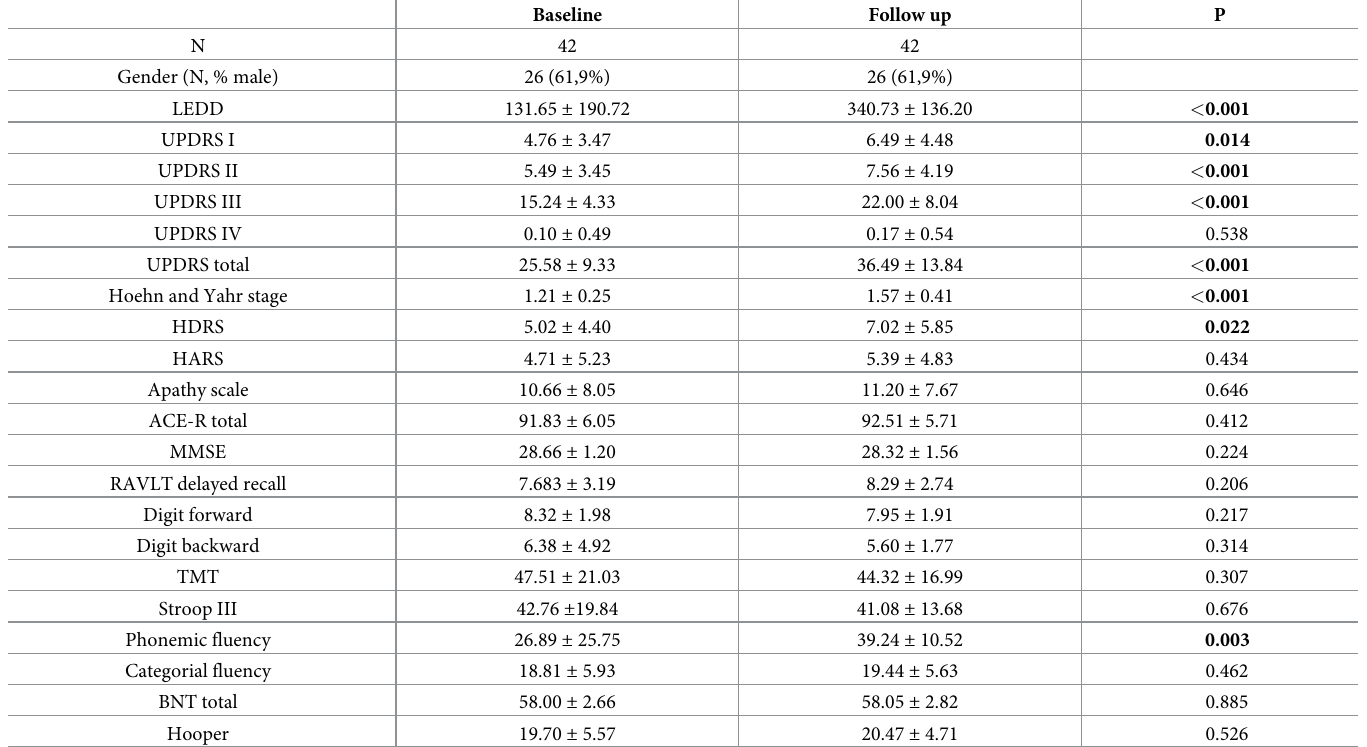
Table 1. Baseline characteristics of patients and at one year follow